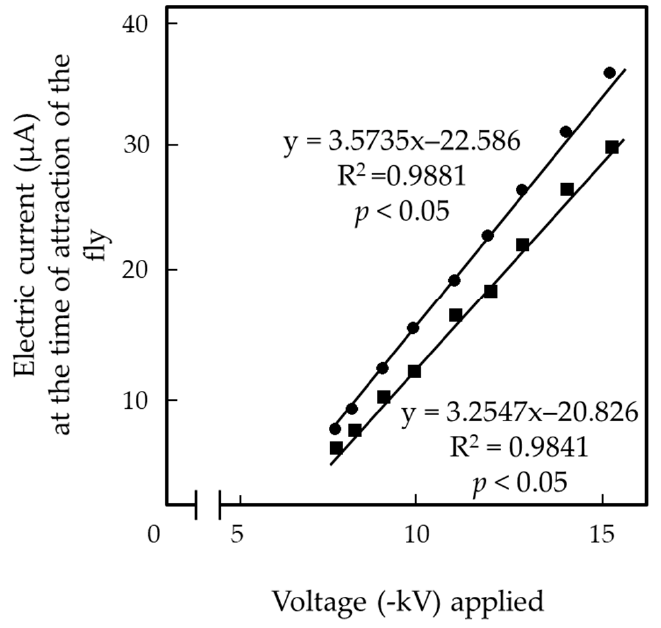
Figure 6. Linear correlation between the voltage applied to the PIP of the EFP and the electric current generated by 7-day-old male and female houseflies upon attraction to the N-PIP.